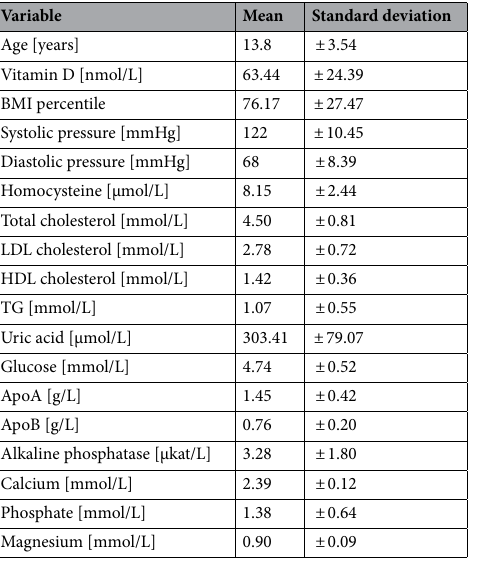
Table 1. Descriptive statistics with mean values and standard deviations of clinical and laboratory parameters of all included subjects. BMI Percentile body mass index percentile, LDL cholesterol low-density lipoprotein cholesterol, HDL cholesterol high-density lipoprotein cholesterol, TG triglycerides, ApoA apolipoprotein A1, ApoB apolipoprotein B.